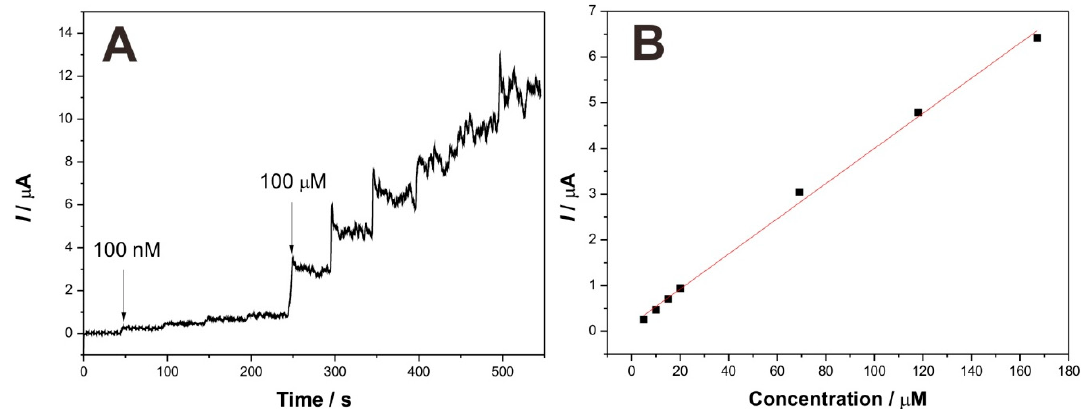
Figure 7. Typical current–time response curve of the GCE/Lac-PdBC-Nafion upon successive additions of dopamine into pH 7.0 PBS, applied potential: 0.4 V ( A ); Calibration curve of steady-state currents vs. dopamine concentrations ( B ). Table 1. Sensing performance comparison of different sensors toward dopamine.